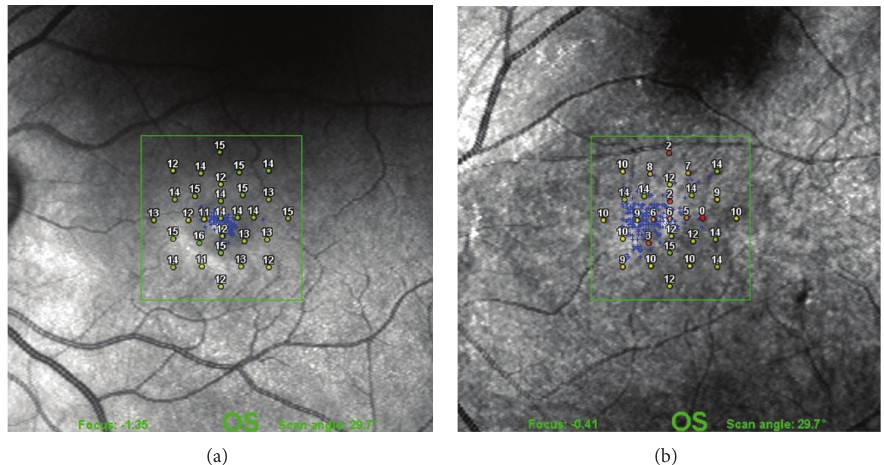
Figure 5: Scanning laser ophthalmoscope microperimetry after idiopathic macular hole surgery. (a) One month after surgery without ILM peeling showing normal retinal sensitivity and no deep microscotomas in the central 9 degrees of the visual field. (b) Two months after surgery with ILM peeling showing decreased mean retinal sensitivity and deep absolute and relative microscotomas in the central 9 degrees of the visual field